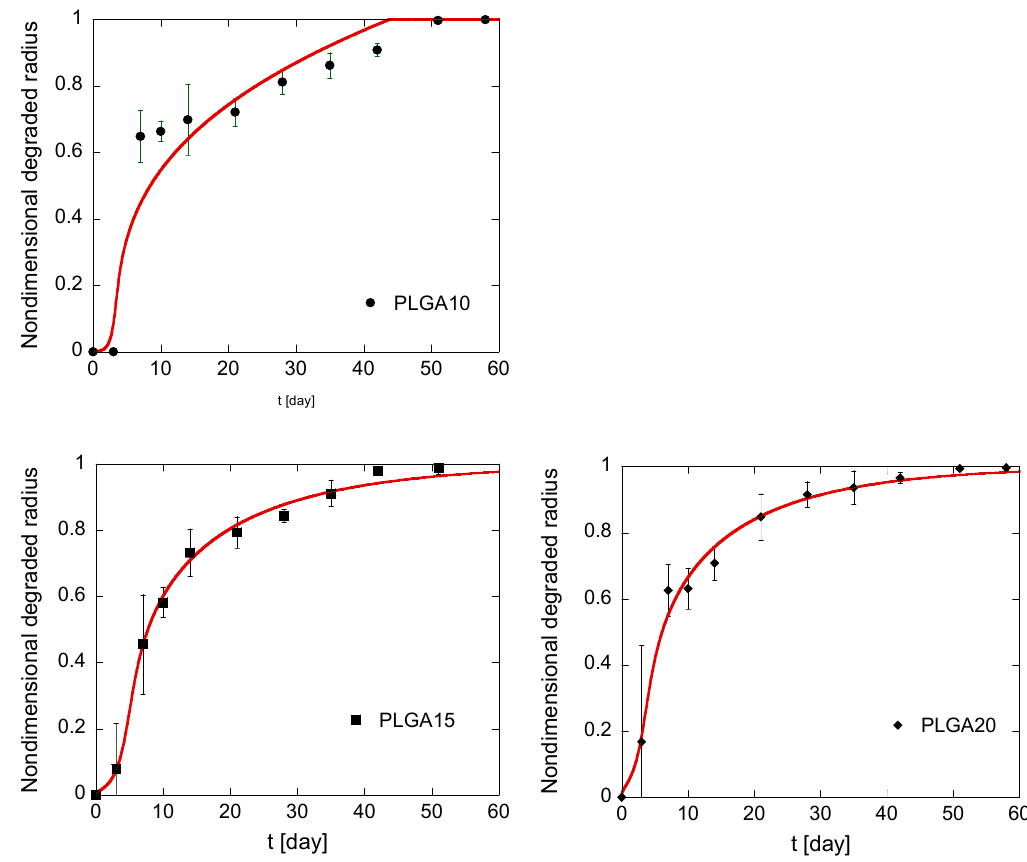
Figure 6. Kinetics of the degradation front of PLGA MS in different compositions. The model simulations, fitting the experimental data reported in black, are represented by solid red lines.